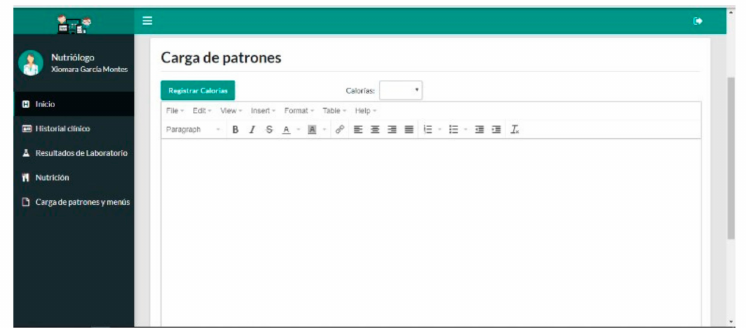
Figure 33. Nutritionist application interface: Loading of the food standard.